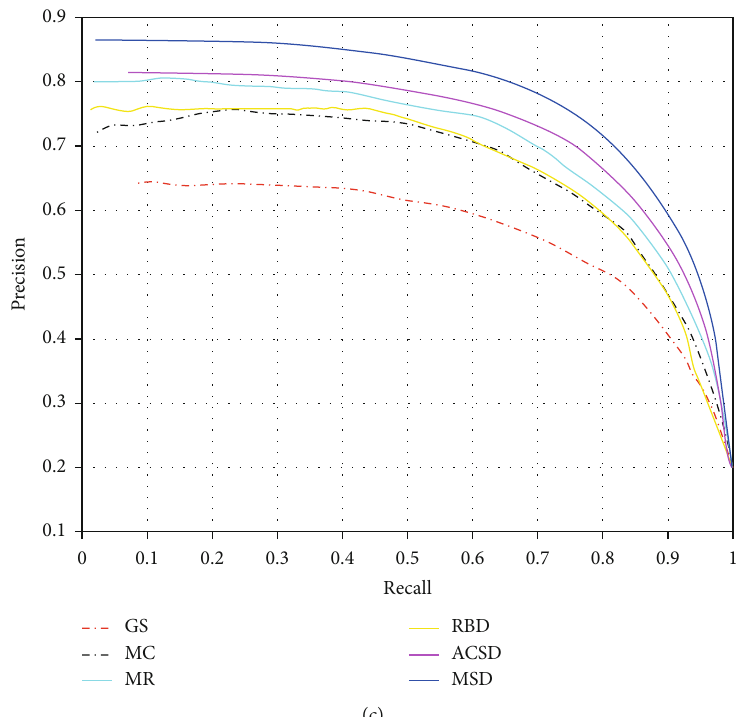
Figure 4: The precision-recall curves of di ff erent algorithms: (a) the precision-recall curves on the N group; (b) the precision-recall curves on the S/C group; (c) the precision-recall curves on full datasets.